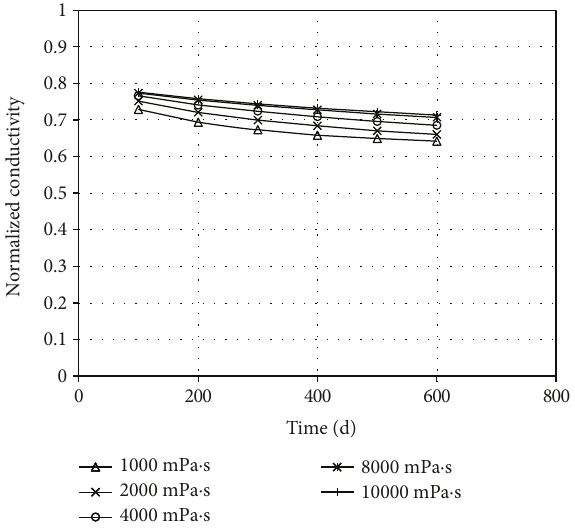
Figure 8: E ff ect of proppant diameter on conductivity at di ff erent closure pressures.